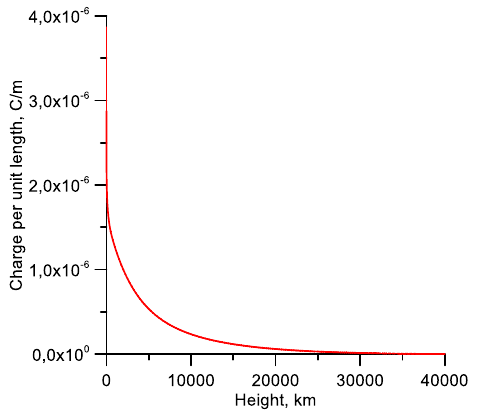
Figure 2. The charge per unit length induced on the macro channel when its tip is at ground level (2 m above the ground) by the fair-weather atmospheric electric